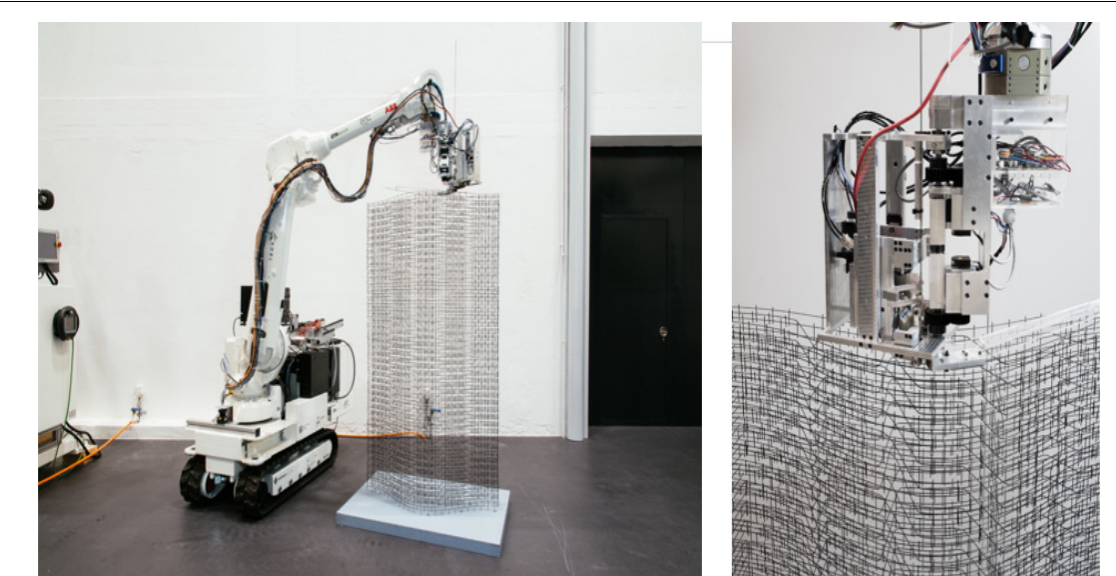
Figure 2. (Left) Mesh Mould produced with the In Situ Fabricator robot from ETH Zurich dfab. (Right) Close up of In Situ Fabricator tool